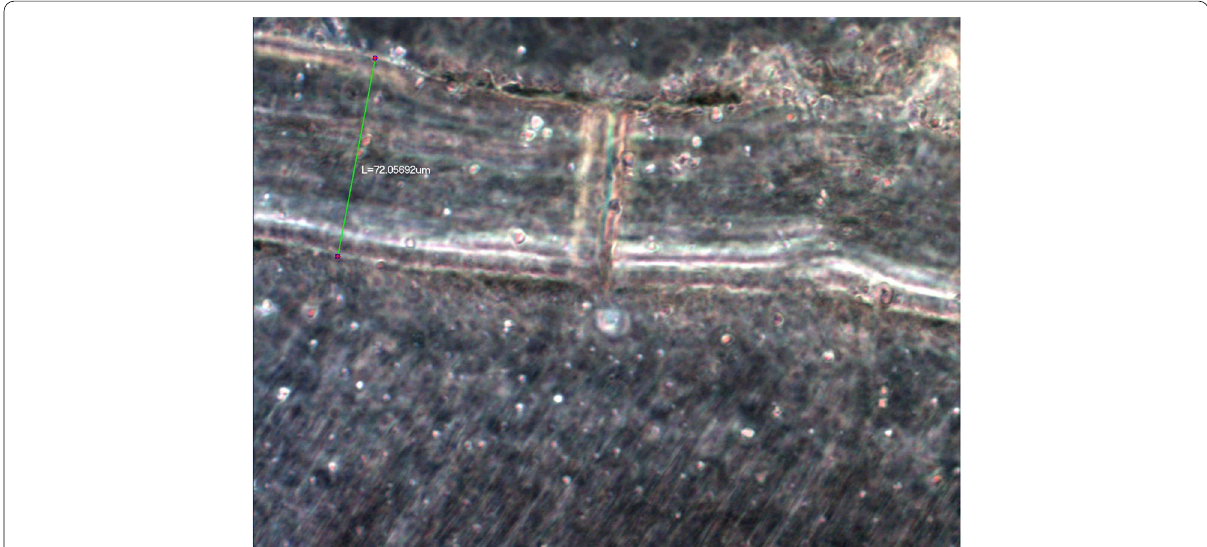
Fig. 1 Photomicrograph of normal tooth showing measurement of the total width of cementum (ground section